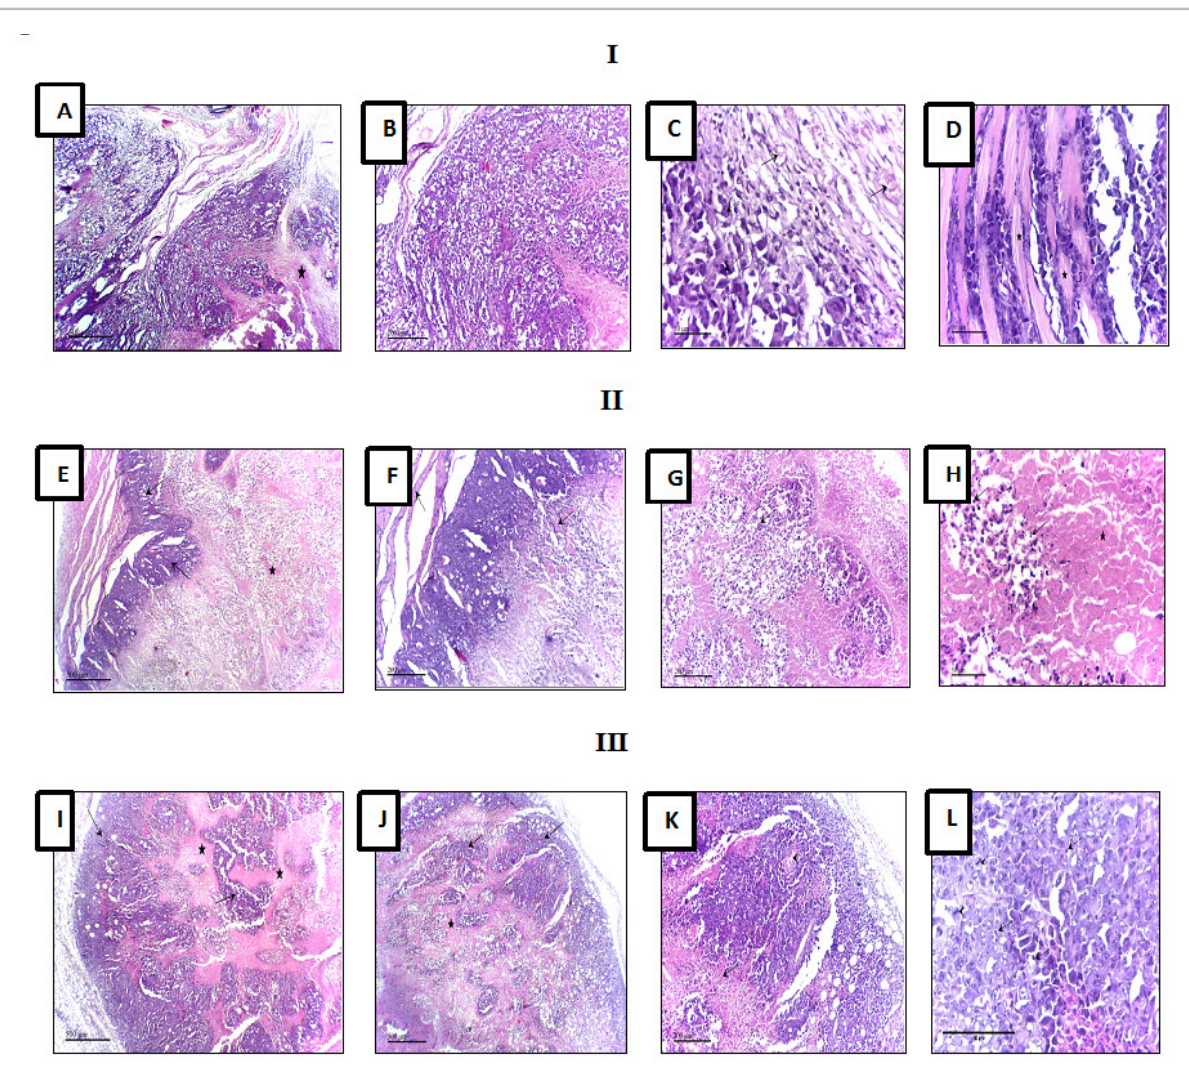
FIGURE 7 - Effect on tumor histopathological